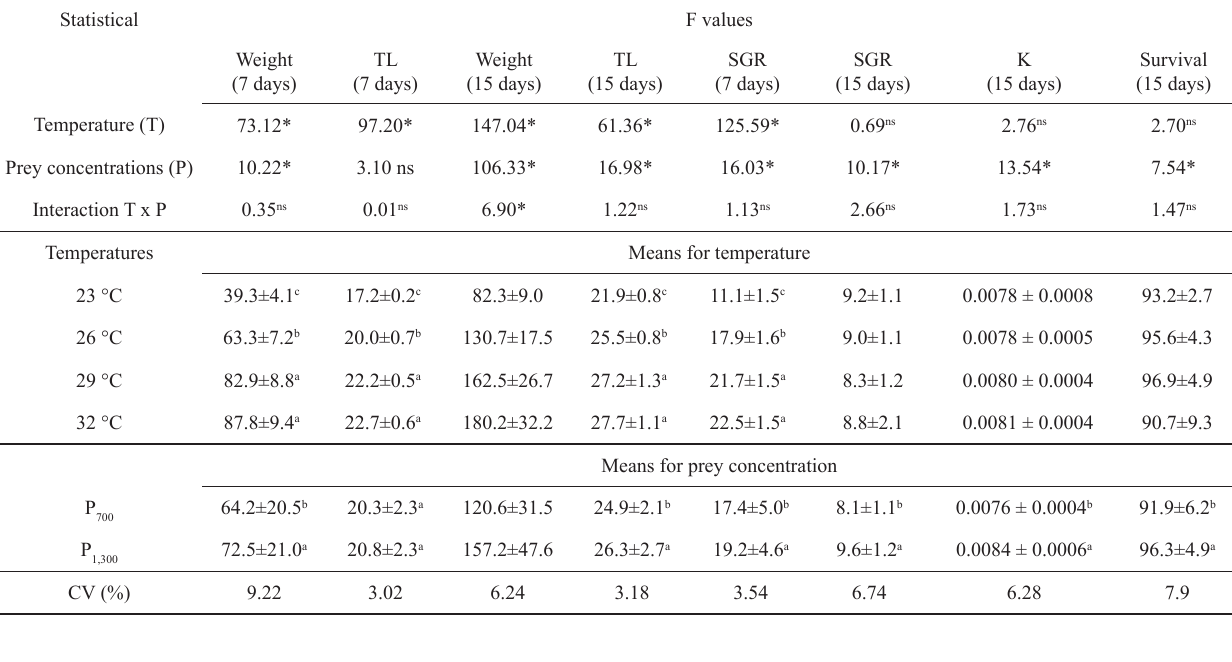
Table 2 . Weight (mg), total length (TL) (mm), specific growth rate (SGR) (% day -1 ) after 7 and 15 days of exogenous feeding of Lophiosilurus alexandri . The Fulton’s condition factor (K) and survival (%) were calculated at the end of the experiment . F values and means ± standard deviation ( P <0.05). Means followed by the same letters on the columns did not differ by Tukey’s test ( P <0.05). * P <0.05. ns – Not significant. CV - coefficient of variation.